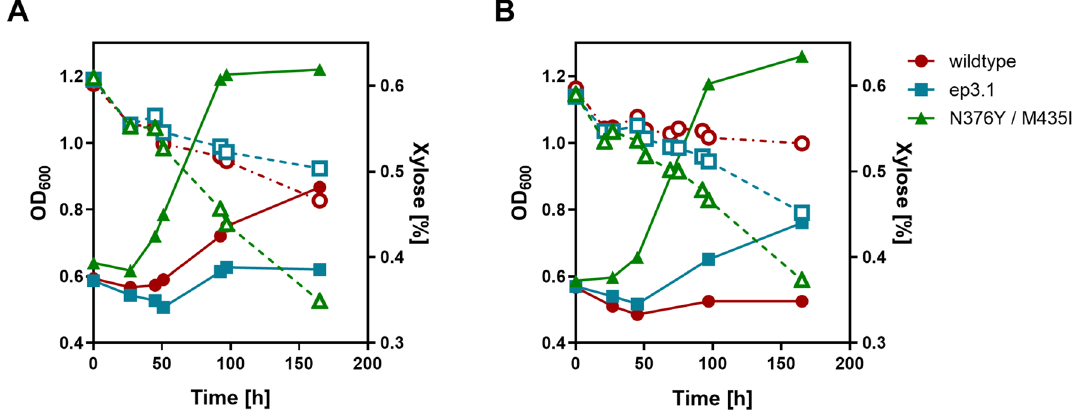
Figure 1. Fermentation of the screening strain AFY10X transformed with different Gal2 variants. The Gal2 constructs (wildtype, the selected mutant ep3.1 and the N376Y/M435I double mutant) were expressed from multicopy plasmids in the hxt 0 /hxk 0 strain AFY10X. The consumption of xylose (0.5% w/v; open symbols, dashed lines) in the absence ( A ) or presence ( B ) of glucose (2% w/v) and growth curves (OD 600 ; closed symbols, full lines) are shown. The mean values of three independent cultures are shown. The error bars are omitted for clarity.